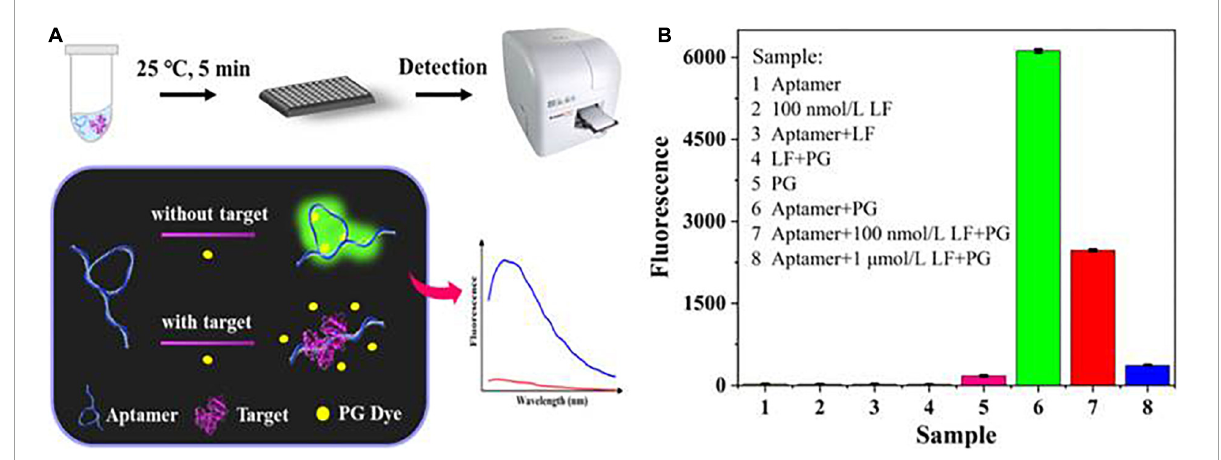
FIGURE1 (A) The principle of the label-free aptasensor strategy for LF detection. (B) Feasibility verification of the